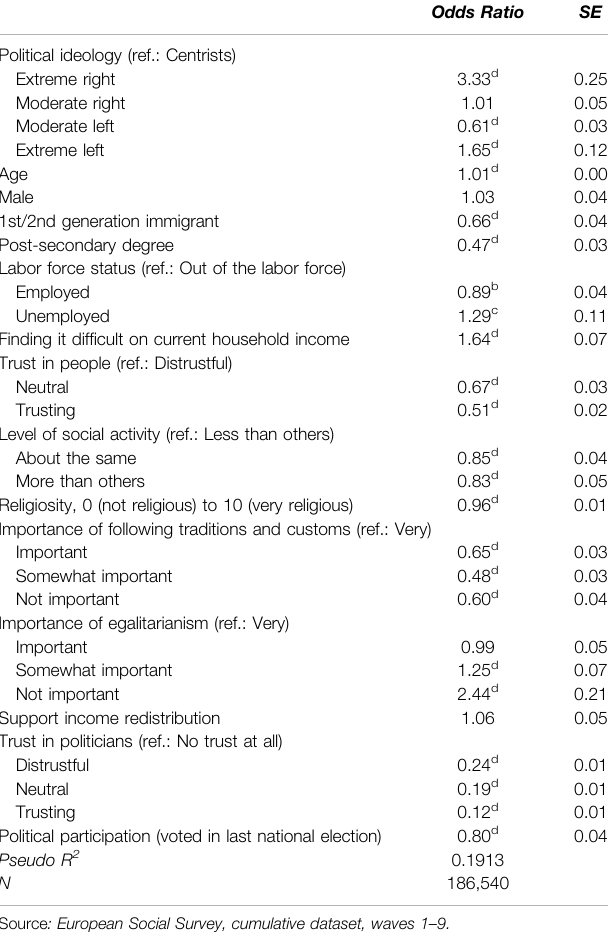
TABLE 2 | Results from logistic regression on extremely anti-immigrant attitudes (Odds